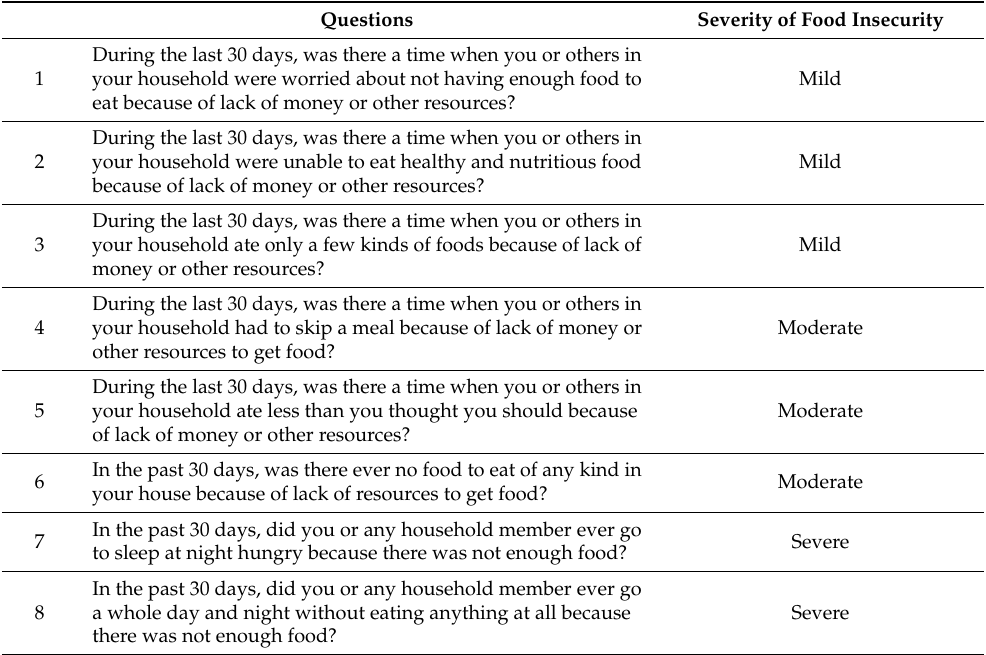
Table 1. FIES Questionnaire.